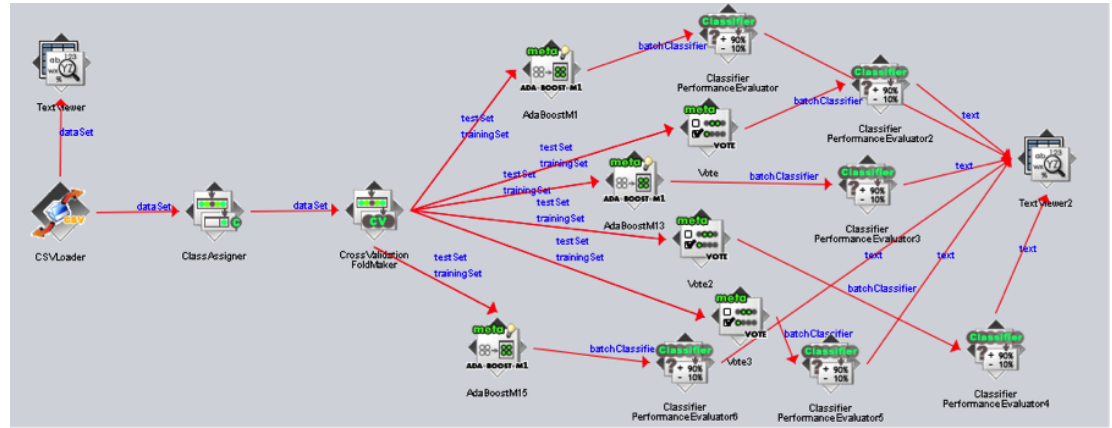
Figure 8. Ensemble method (boosting) implementation using